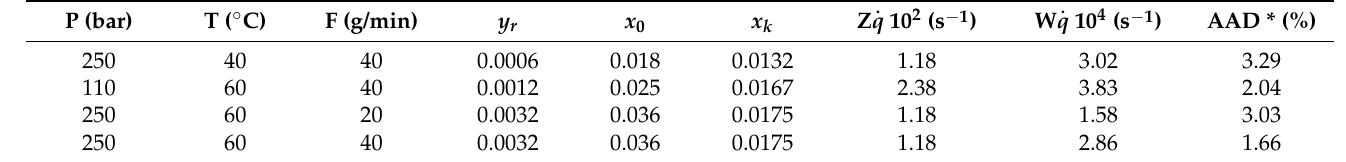
* absolute average deviation of the experimental from the predicted points (see Equation